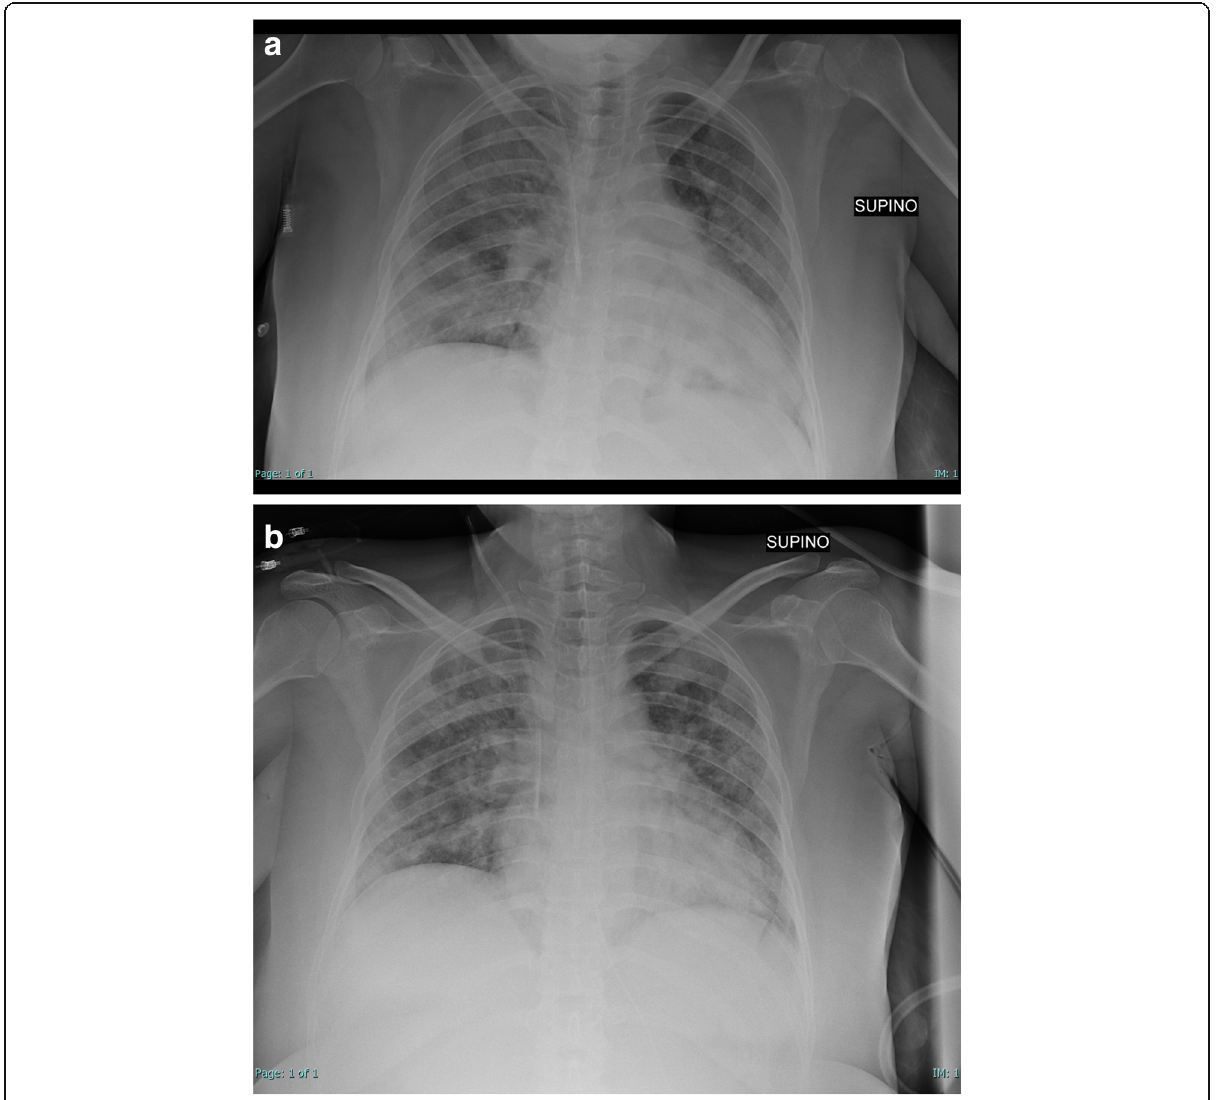
Fig. 1 a Chest radiography of the pregnant woman before intubation, at ICU admission. b Chest radiography of the pregnant woman after extubation (15th